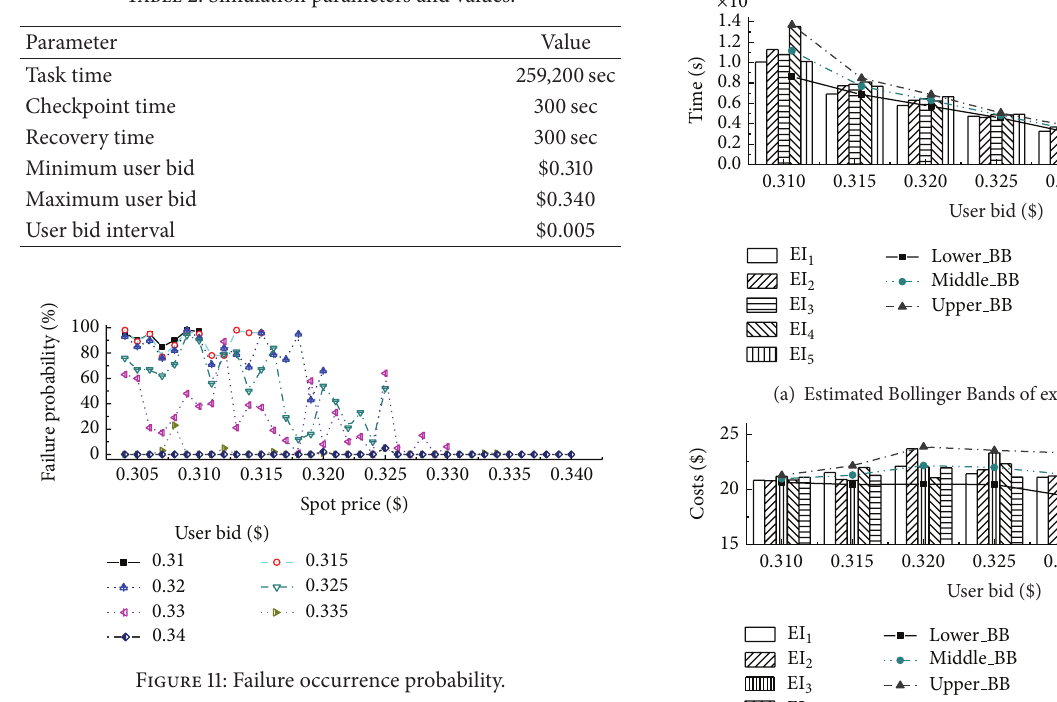
Table 2: Simulation parameters and values.